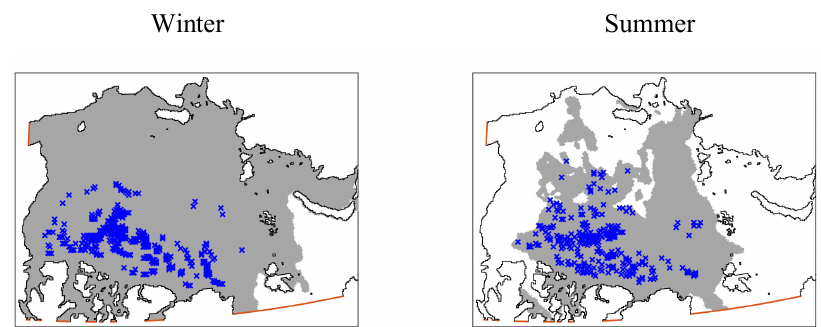
Figure 14. Maps showing the positions (blue crosses; 603 during winter and 344 during summer) of the IABP buoy trajectory dataset used in this study as starting point of the ensemble trajectory simulations performed with the neXtSIM and FD models. The grey area marks the presence of the sea ice during at least 10 consecutive days (the length of the simulations) during the winter and summer periods.